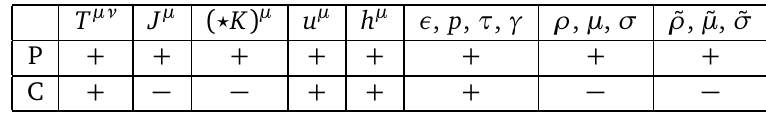
Table 1: Charges under discrete symmetries for 0-form